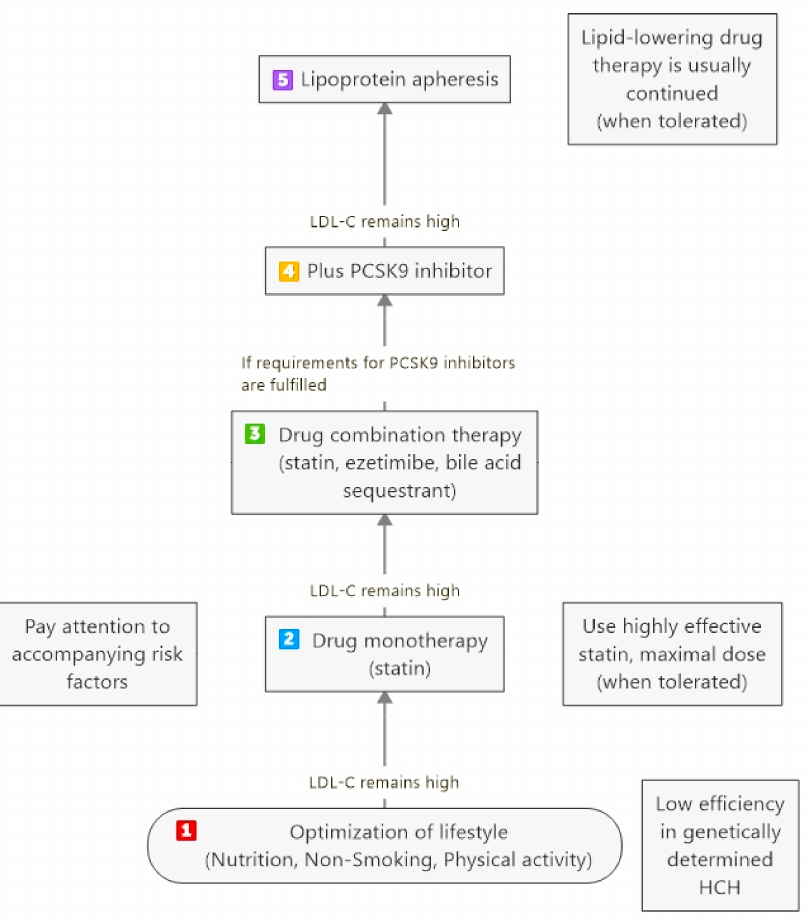
Figure 1. Steps to treat severe hypercholesterolemia (HCH)—from lifestyle to lipoprotein apheresis